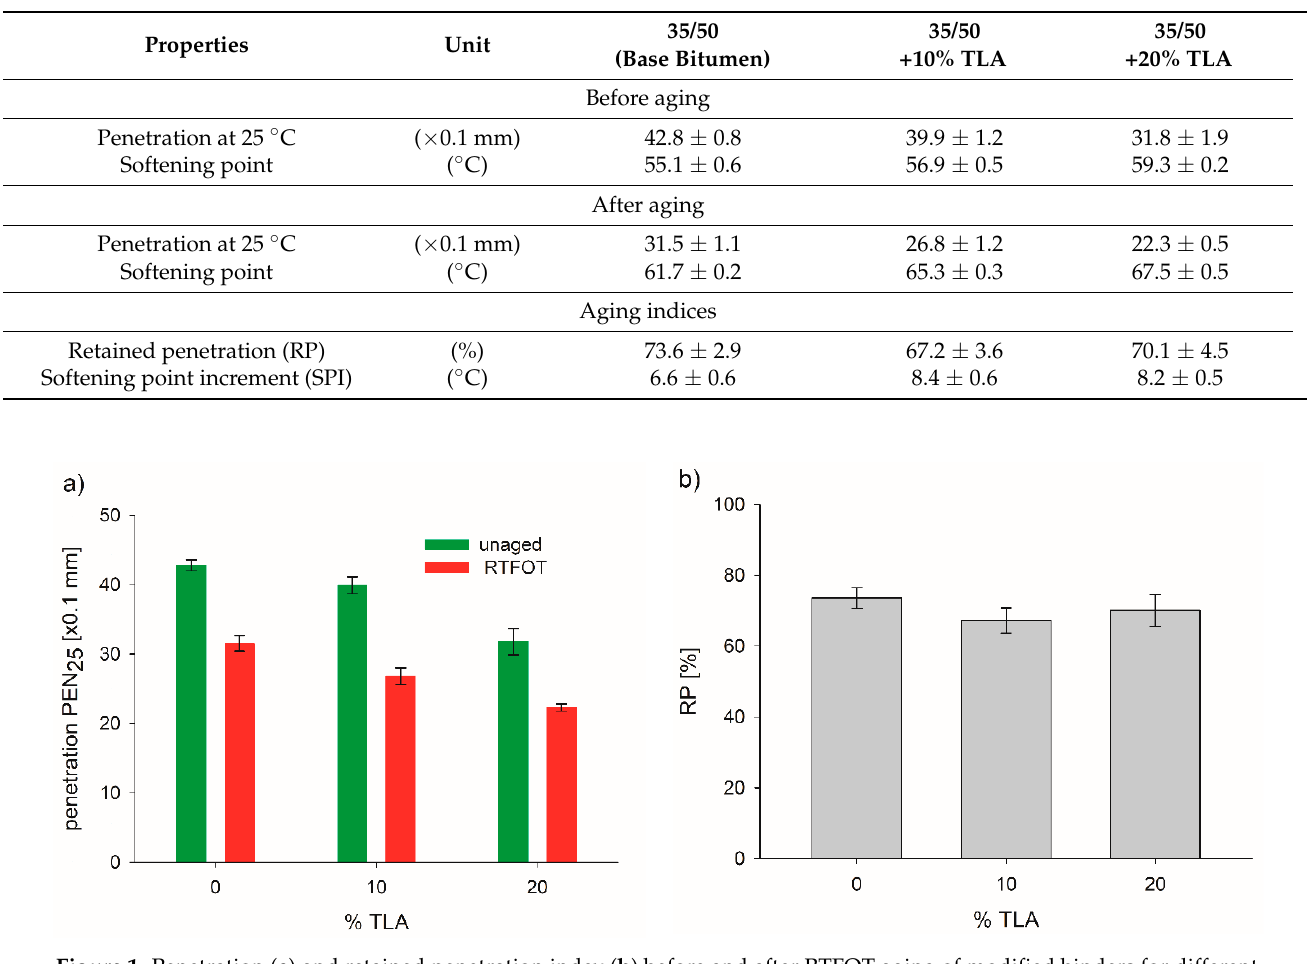
Figure 1. Penetration ( a ) and retained penetration index ( b ) before and after RTFOT aging of modified binders for different TLA contents.